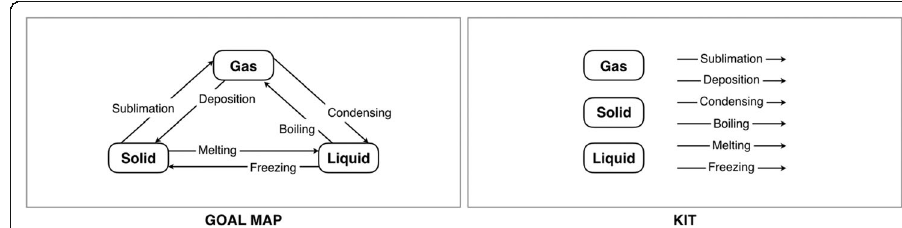
Fig. 1 An example of the goal map and its kit